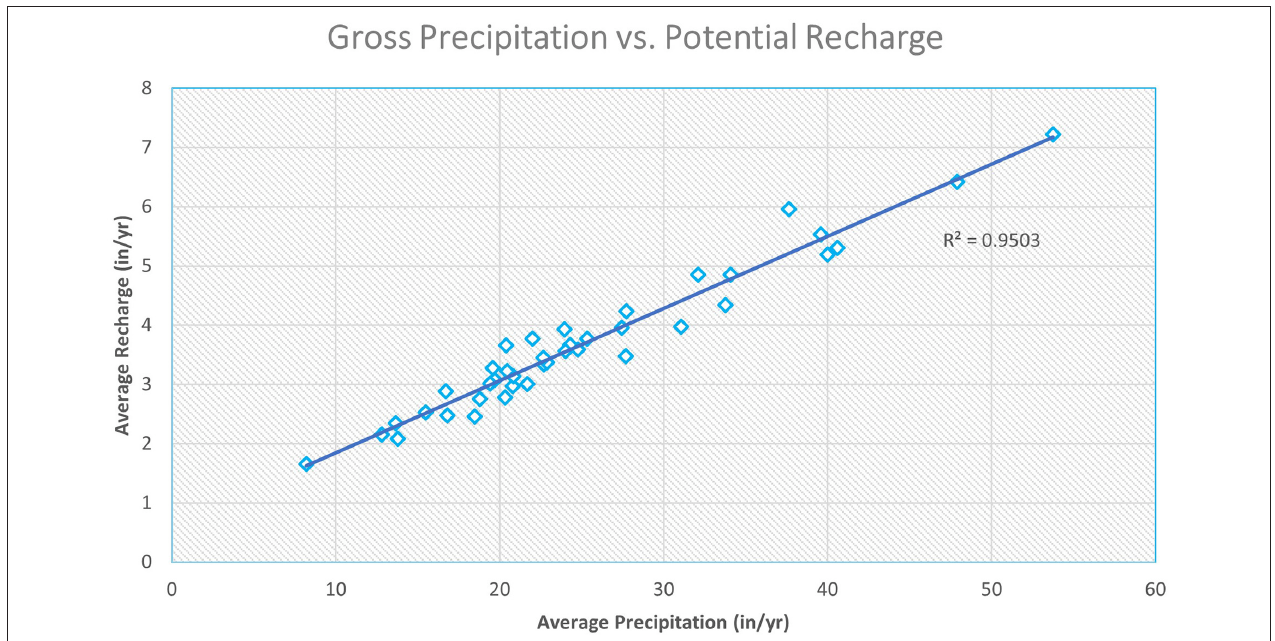
FIGURE 7 | Linear regression plot of spatially-averaged gross precipitation vs. SWB recharge across calibrated watershed during study